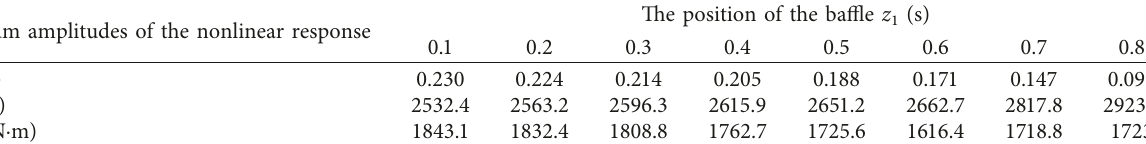
� 0 . 5 m. 1 The position of the baffle z 1 (s)